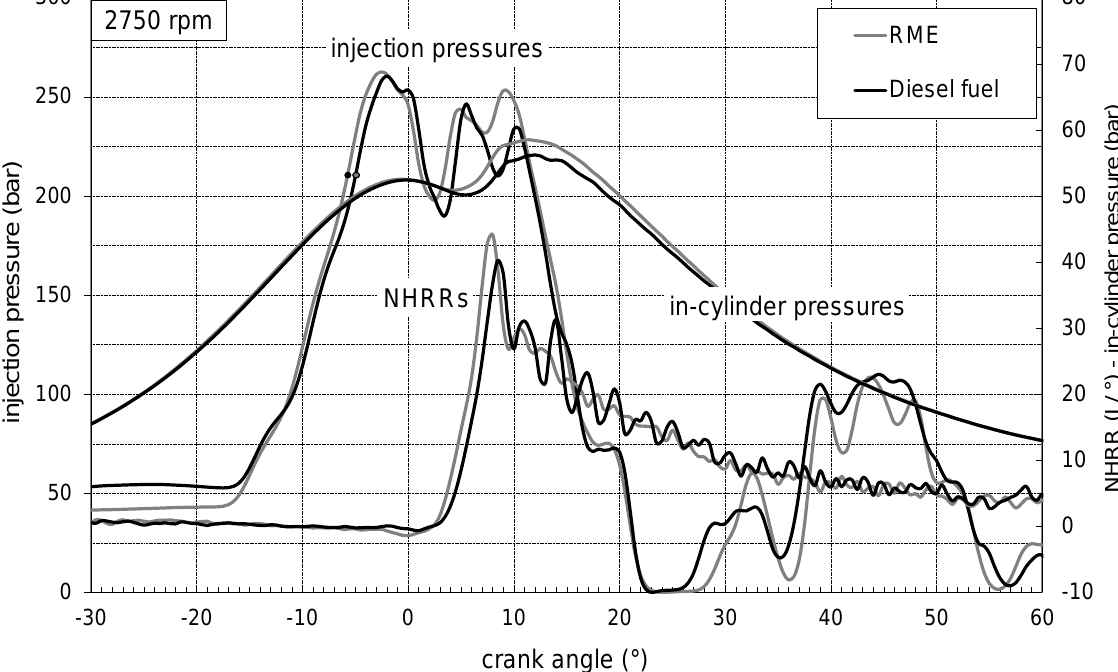
Figure 10. RME and diesel fuel injection pressures, in-cylinder pressures, and NHRR at 2750 rpm and at full load.